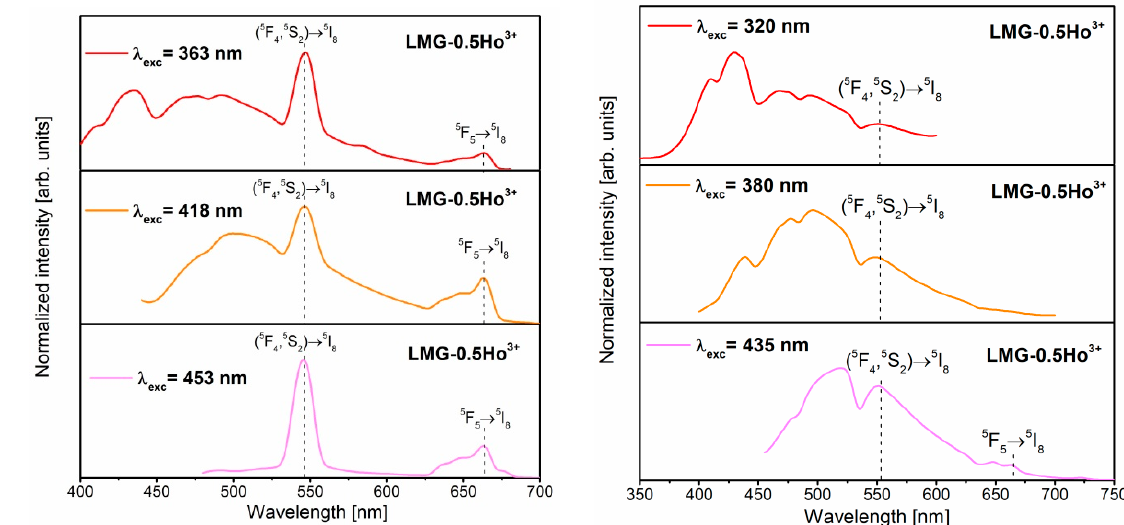
Figure 8. Emission spectra of LMG-Ho 3+ under direct excitation of holmium ions ( left ) and host matrix ( right ).